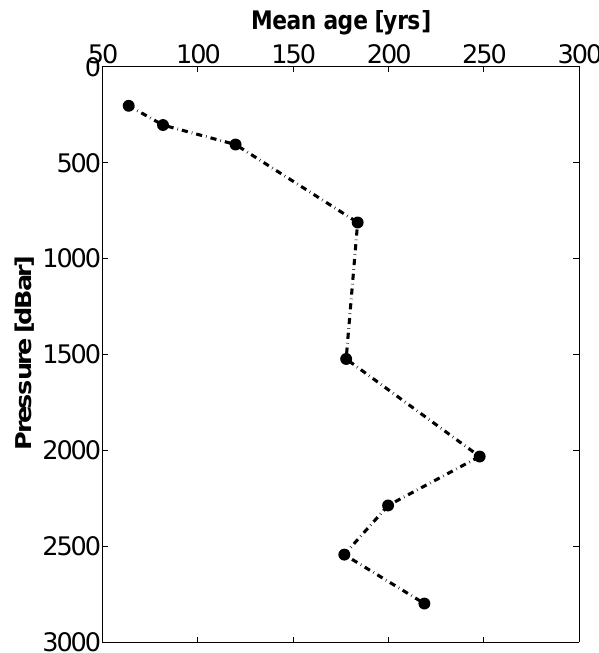
Figure 19. Mean age at station 323 in the WMed based on a 2IG- TTD constrained by the transient tracer couple CFC-12 and SF 6 . Fig. 19: Mean age at station 323 in the WMed based on a 2IG-TTD constrained by the transient tracer couple CFC-12 and SF Table 5. Number of constrained data points of the IG- and 2IG-TTD using SF 6 , CFC-12 and